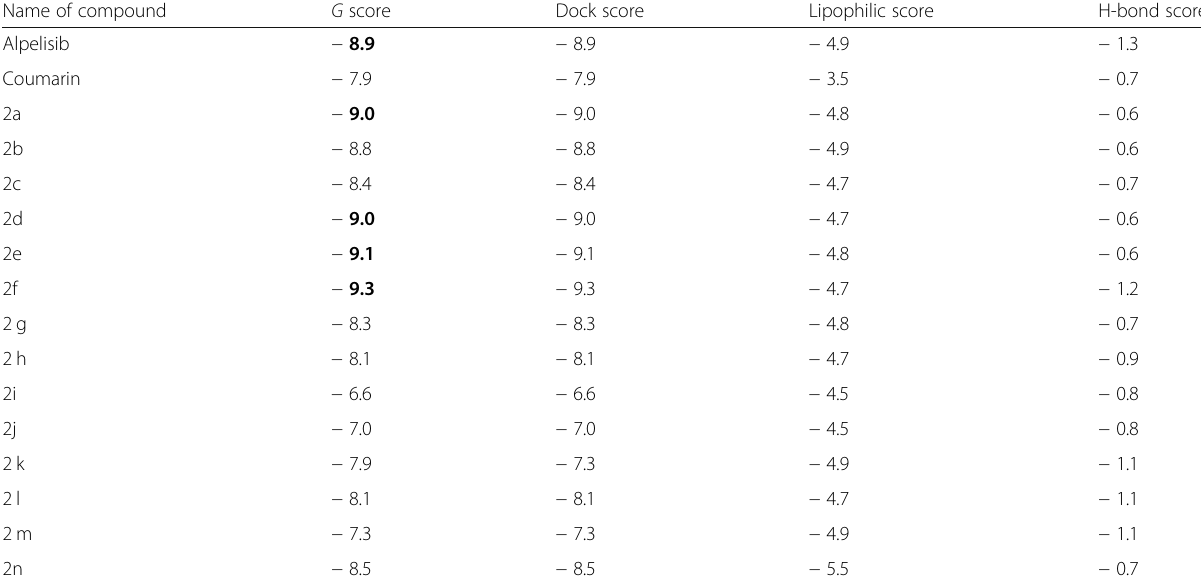
Table 5 Schrödinger Maestro Docking score (kcal/mol) of compounds against PIK3CA (PDB ID: 5DXT) Name of compound G score Dock score Lipophilic score H-bond score Alpelisib − 8.9 − 8.9 −